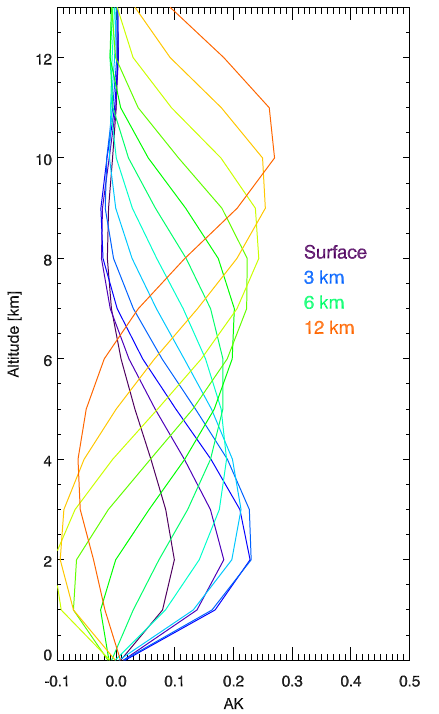
titudes of the maximum of the integrated AK for the surface (cid:0) 6 km TOC (bottom left), and the altitudes of the maximum of the integrated AK for the surface (cid:0) 3 km TOC (bottom right), for MAGEAQ-TIR. Mean values and standard deviations are also reported in red (mean/SD). The data cover the Fig. 1. Averaging kernels from surface to 12km for a single typ-